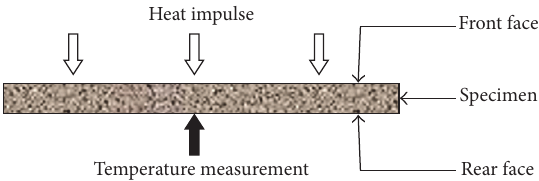
Figure 1: Principle of the flash methodology and